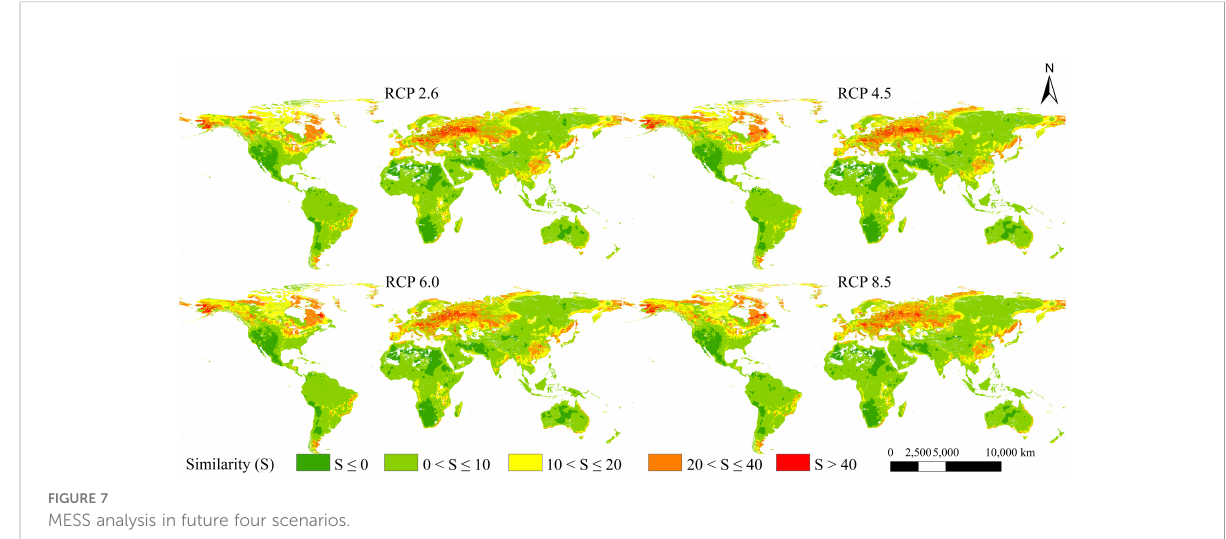
FIGURE 7 MESS analysis in future four scenarios.